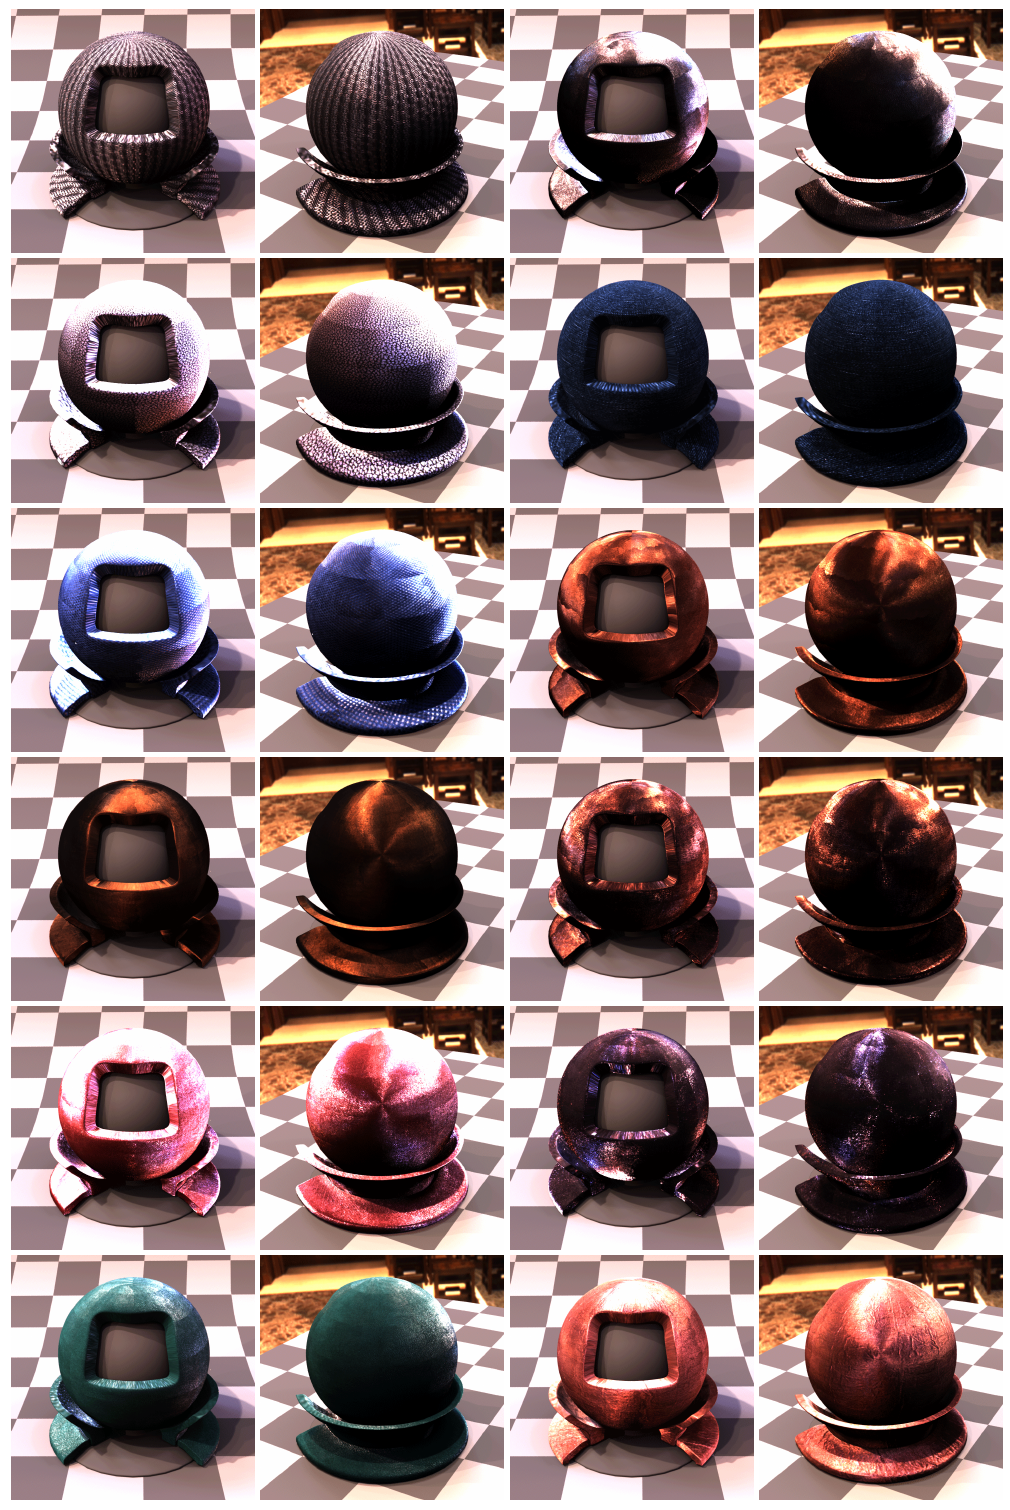
Figure 26. Twelve textile and upholstery material samples, measured by lightdrum, put onto the 3D object and rendered by Mitsuba rendering software under two different views. Materials (top-left to bottom-right): treves2, black leather, tres5, blue denim, fabric003, fabric111, fabric112, fabric135, fabric136, fabric137, fabric300, brocadi001. The materials fabric003, fabric111, fabric112, fabric135, fabric136, fabric137 are courtesy of Jiˇrí